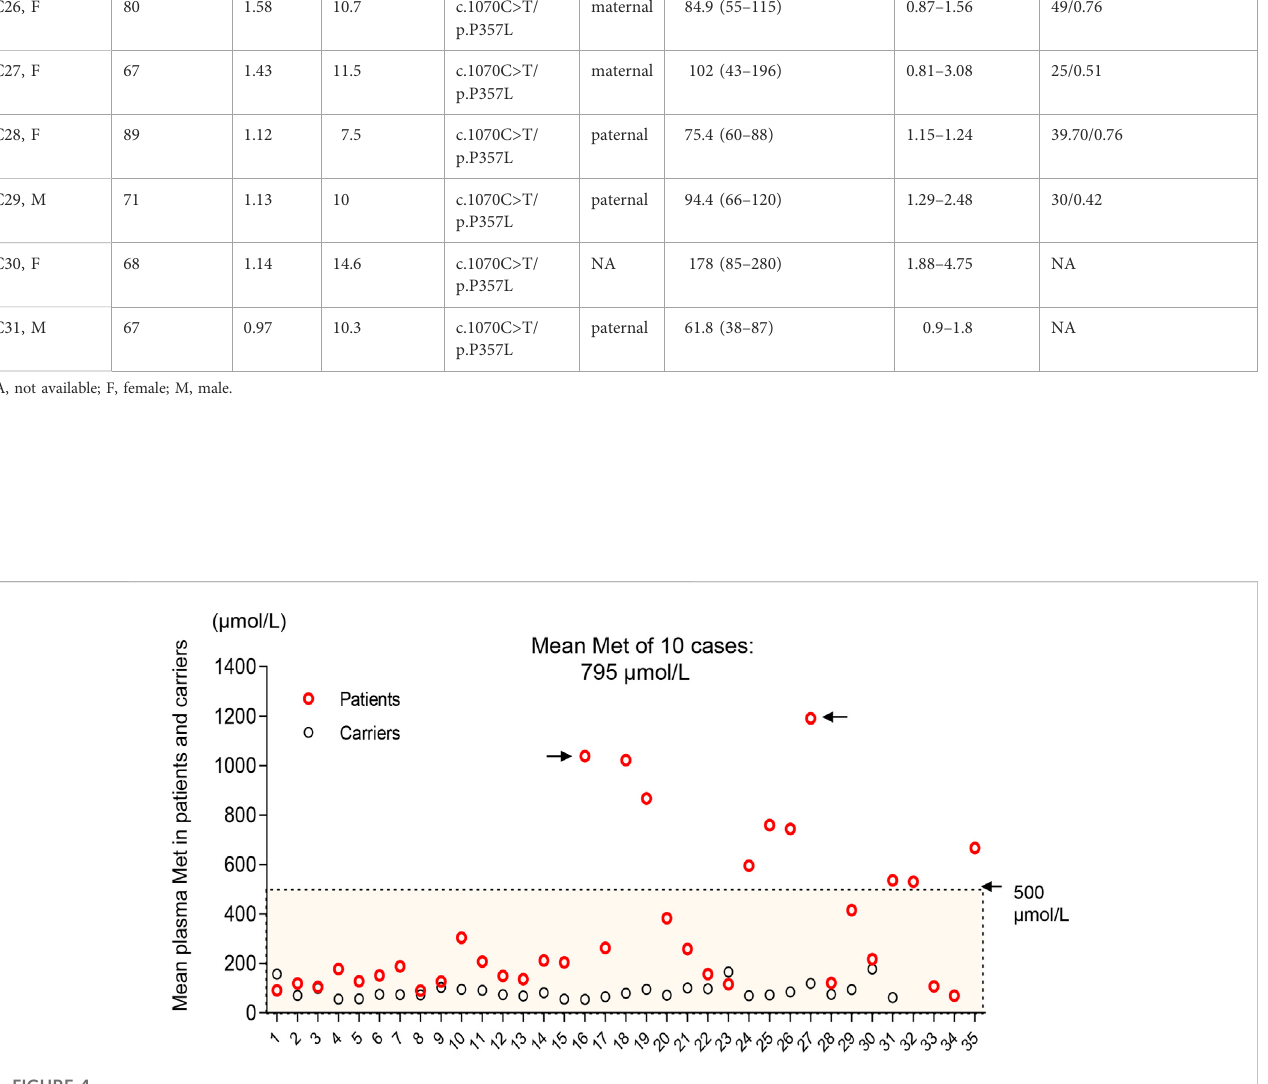
Frontiers in Cell and Developmental